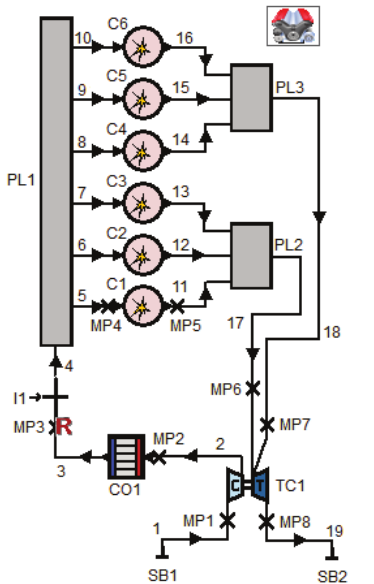
Fig. 3. The structure of the engine model developed in AVL BOOST: SB1, SB2 – system boundaries; MP1–MP8 – measuring points; TC1 – turbocharger; CO1 – air cooler; R – reference point for volumetric effi- ciency; I1 – gas injector; PL1–PL3 – plenums; C1–C6 – cylinders; E1 – engine, 1–18 – connecting